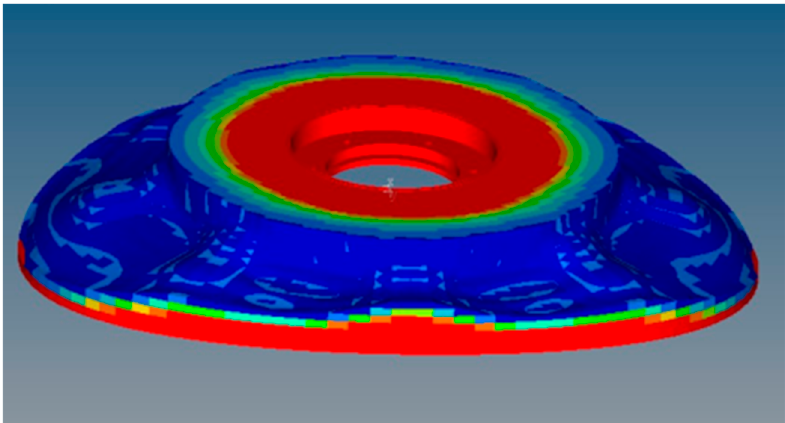
Figure 8. The optimization result at the threshold value 0.1 after 25